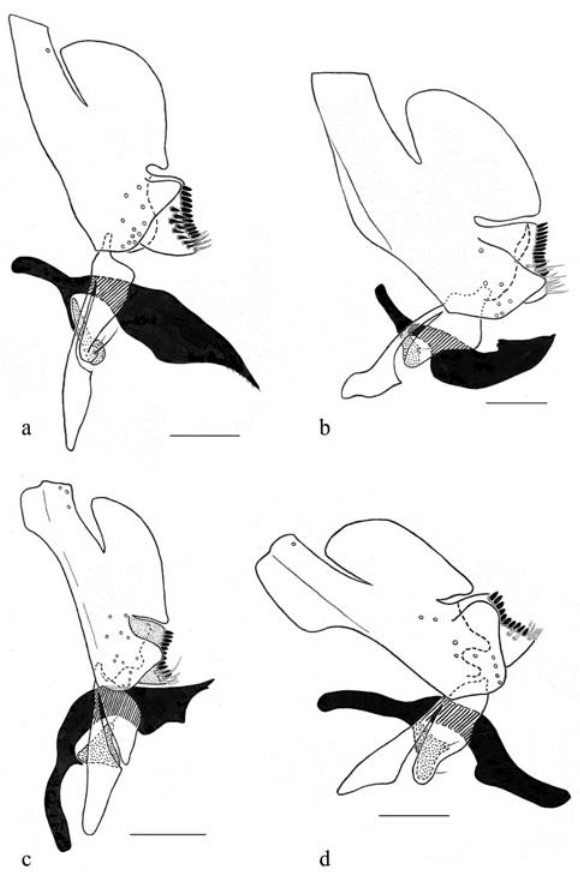
Figure 8 - Male terminalia (aedeagus + aedeagal apodeme are highlighted in black, and paraphysis is highlighted with dots), left lateral view, of: a. Drosophila mulleri Sturtevant, 1921; specimen from Roy Farm, Austin, Texas, USA (probably strain 3370.1 [University of Texas], currently strain 15081-1371.8 [University of Arizona]). b. Drosophila nigrospiracula Patterson & Wheeler, 1942; specimen (no. 23) from Ari- zona, USA (strain 21.58.10 [University of Texas]). c. Drosophila paranaensis Barros, 1950; specimen (no. 623) from Tingo Maria, Depart- ment of Huánuco, Peru. d. Drosophila peninsularis Patterson & Wheeler, 1942; specimen no. 29, from Havana Country Club, Cuba (strain 2377.2 [University of Texas], currently strain 15081.1401.11 [University of Ari- zona]). Scale bars = 0.1 mm.